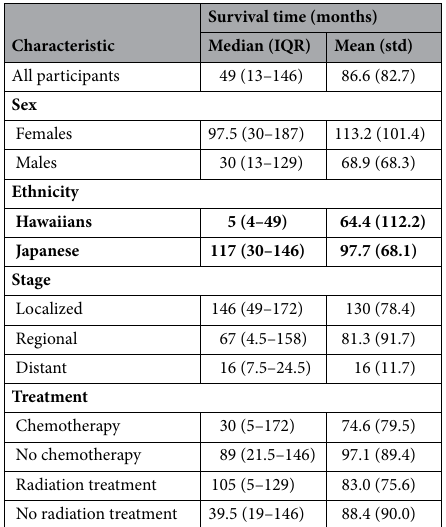
Table 1. Survival among study participants, by ethnicity, stage, and treatment status. Overall Survival Time by Ethnicity are in